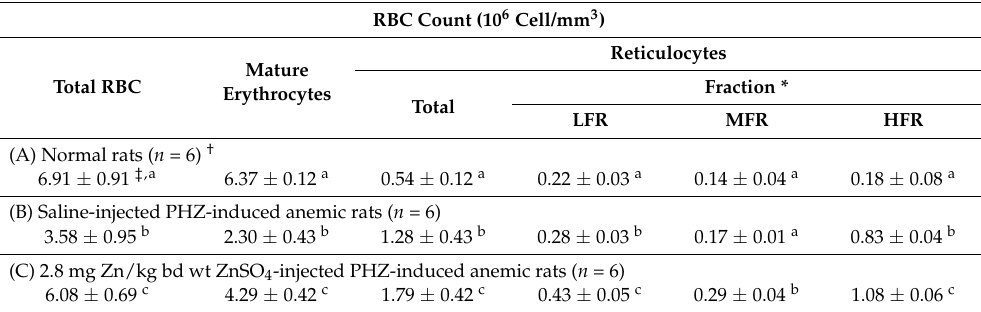
Table 1. Measurements of reticulocytes in normal, saline-injected and ZnSO 4 -injected PHZ-induced rats with an automatic hematology